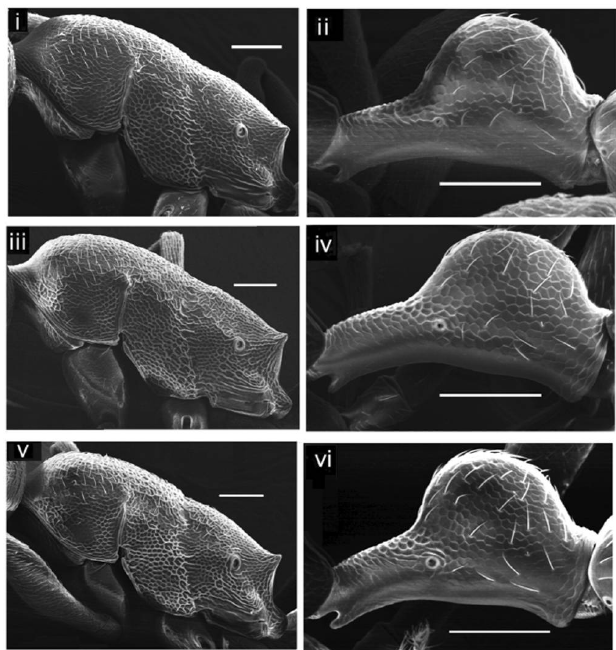
Fig 6. SEM images of the workers of group consisting of lineages A and B (i and ii) of Cardiocondyla sl. kagutsuchi , those of lineage C (iii and iv) and those of lineage D (v and vi). Pictures on the left dis- play a lateral view of the mesosoma and pictures on the right show a lateral view of the petiole. Each scale bar is 100 μm